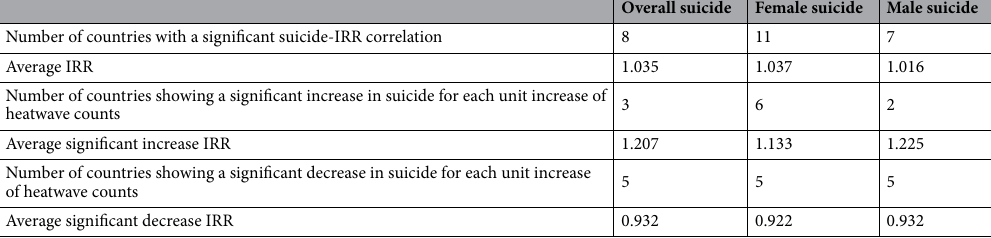
Table 1. Statistically significant suicide and IRR change with respect to heatwave counts on overall and gendered